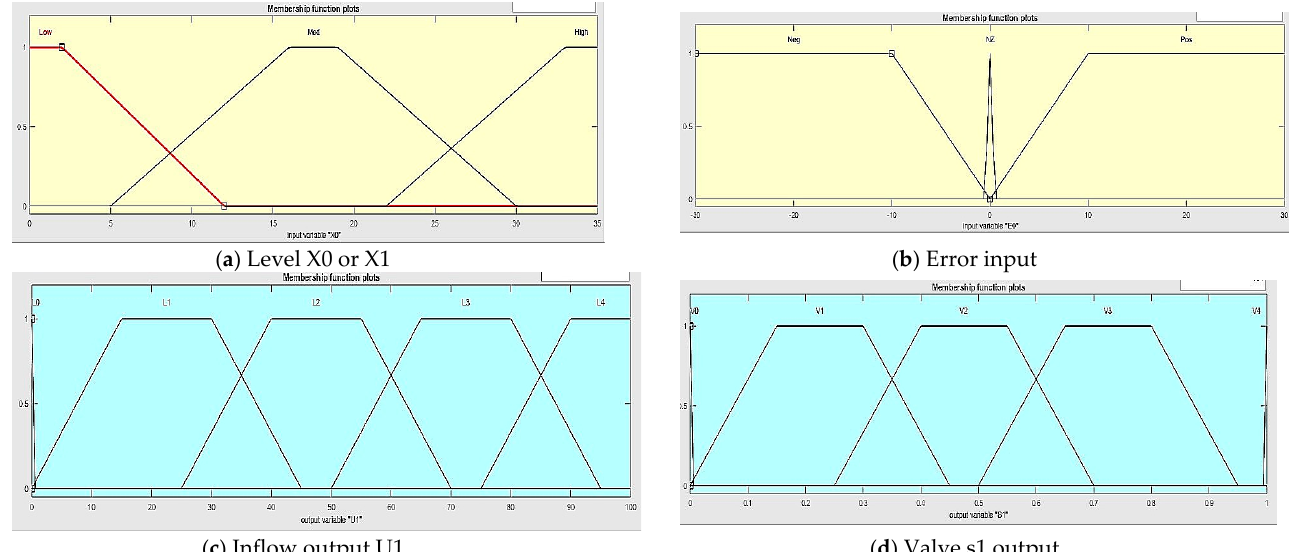
Figure 5. Input and output membership functions for FS1.